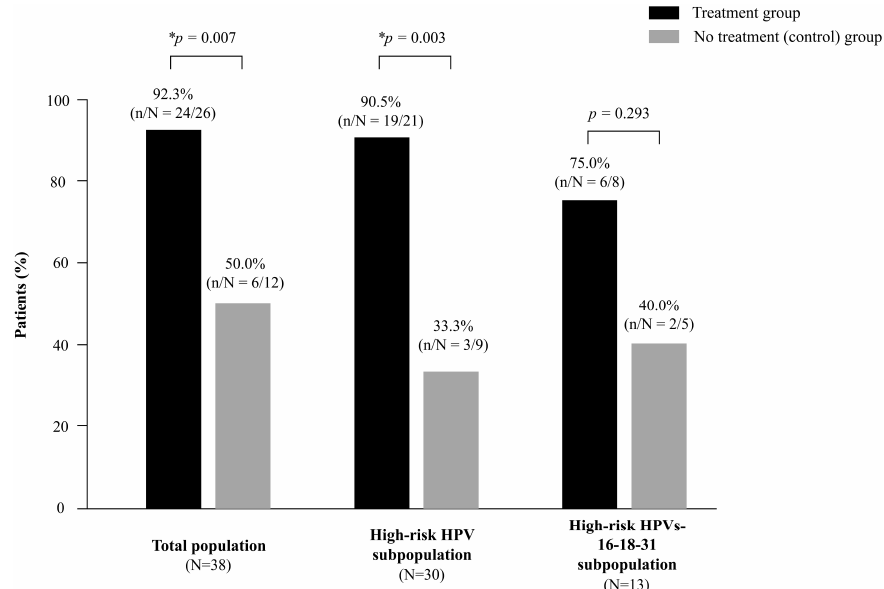
Figure 1. Repair of HPV-dependent low-grade cervical lesions after 6 months of treatment in the total population, HR-HPV and HR-HPV16-18-31 subpopulations pools. Repair of lesions was defined as normalized cytology together with concordant colposcopic observations. * Statistically significant ( p <